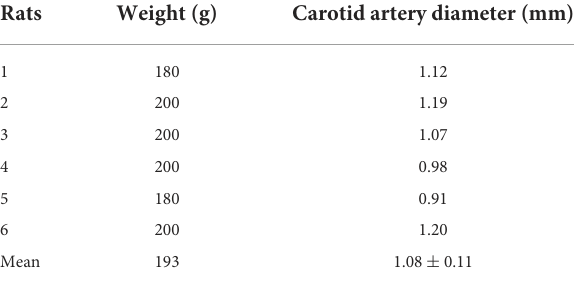
TABLE 2 Diameter of rat’s carotid